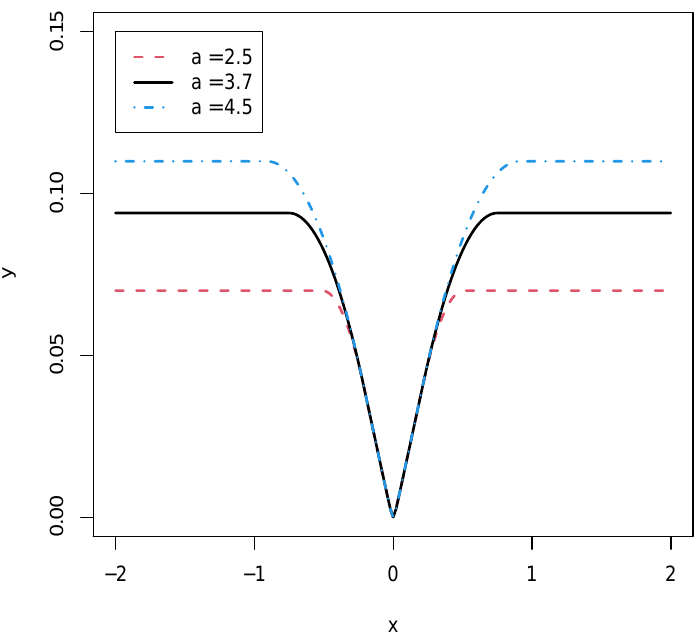
for different values of a for λ = P SCAD